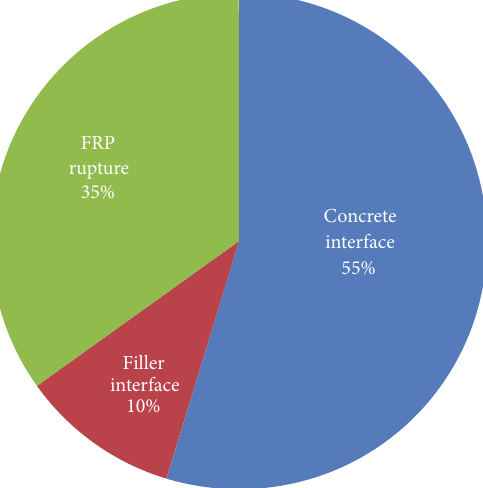
Figure 1: Distribution of the types of failure mode of flexure- strengthened concrete beams (2004–2016, 106 beams strengthened with NSM reinforcement) [5–8, 10,